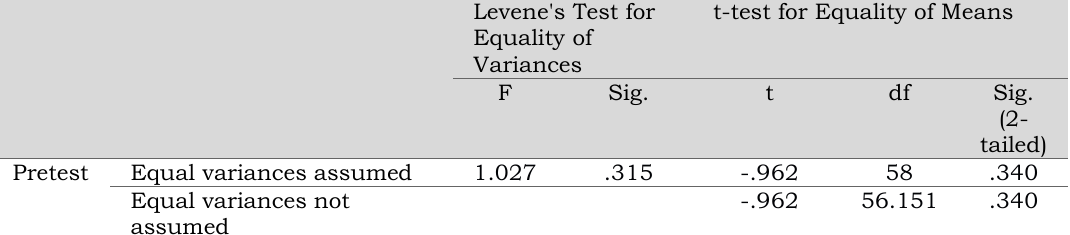
Table 2. Results of independent-samples t-test comparing the pretest scores of